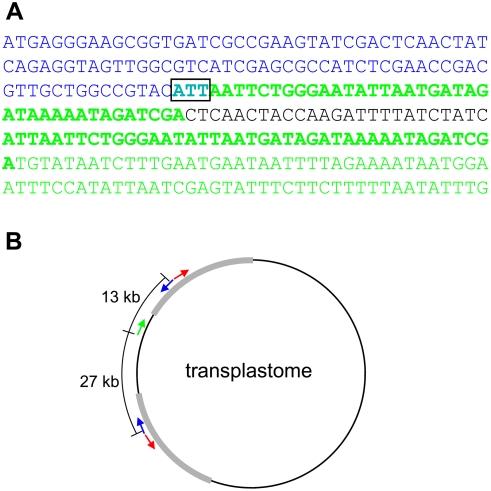
Origin and partial sequence of the kr2.5 nuclear integrant.A. Partial sequence of the kr2.5 nuclear integrant. Blue text indicates aadA sequence, beginning from the start codon, and green text indicates plastid sequence, with the two bold regions being identical. The box highlights a 3 bp region of overlap between aadA and plastid sequences. Black text indicates non-plastid sequence of unknown origin. B. Structure of the transplastome showing the origin of kr2.5 nuclear integrant sequences (not to scale). Neo and aadA are represented by red and blue arrows respectively. They are present in two copies as they are located within the inverted repeats (shown in grey). The green arrow indicates plastid sequence adjacent to aadA in the kr2.5 nuclear integrant. In each case, the direction of the arrow corresponds to the direction of the sequence as written in part A.